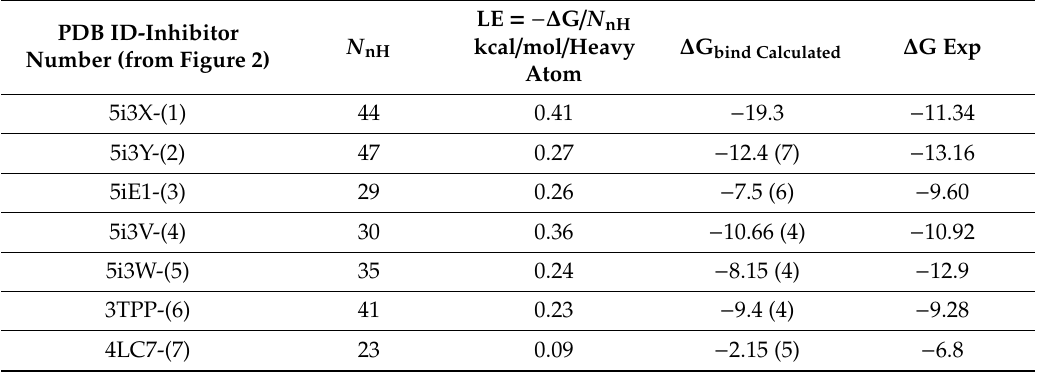
Table 9. Ligand e ffi ciency (LE) and a comparison of ∆ G experimental with the calculated ∆ G values from MM /